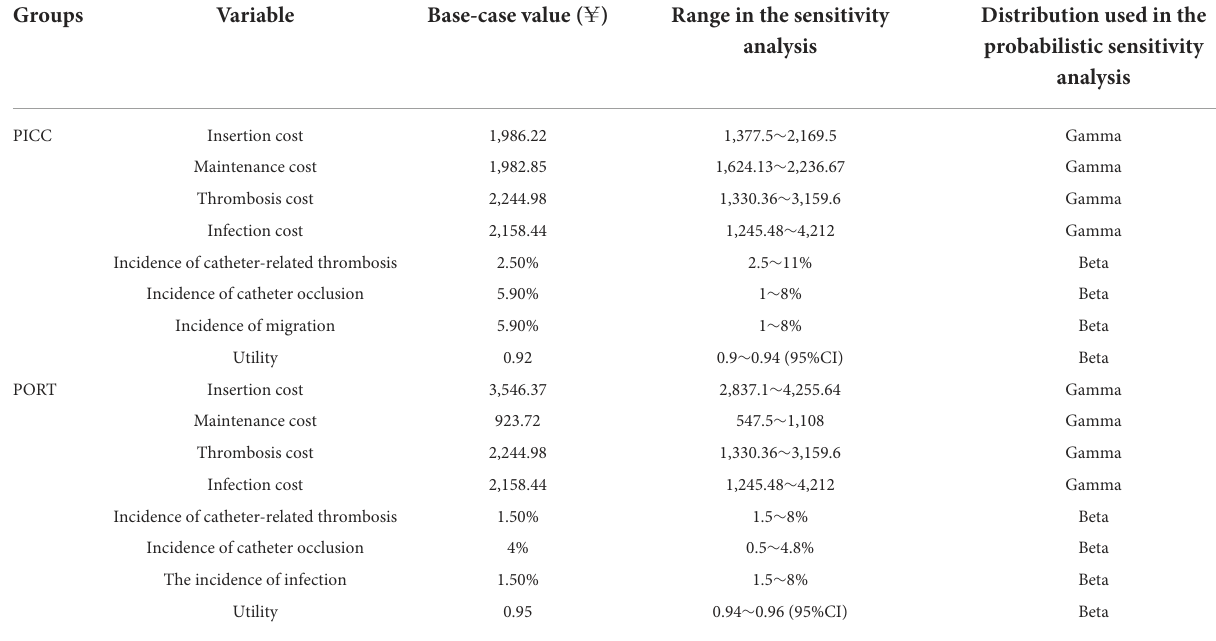
TABLE 2 Distribution type and input values for the sensitivity analysis.